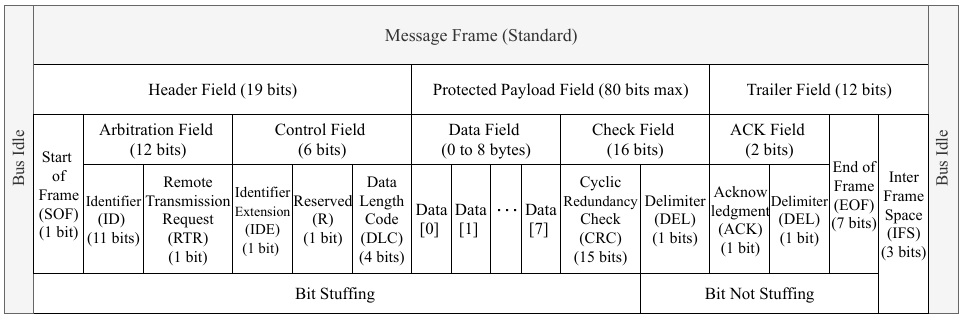
Figure 2. The standard CAN bus message frame